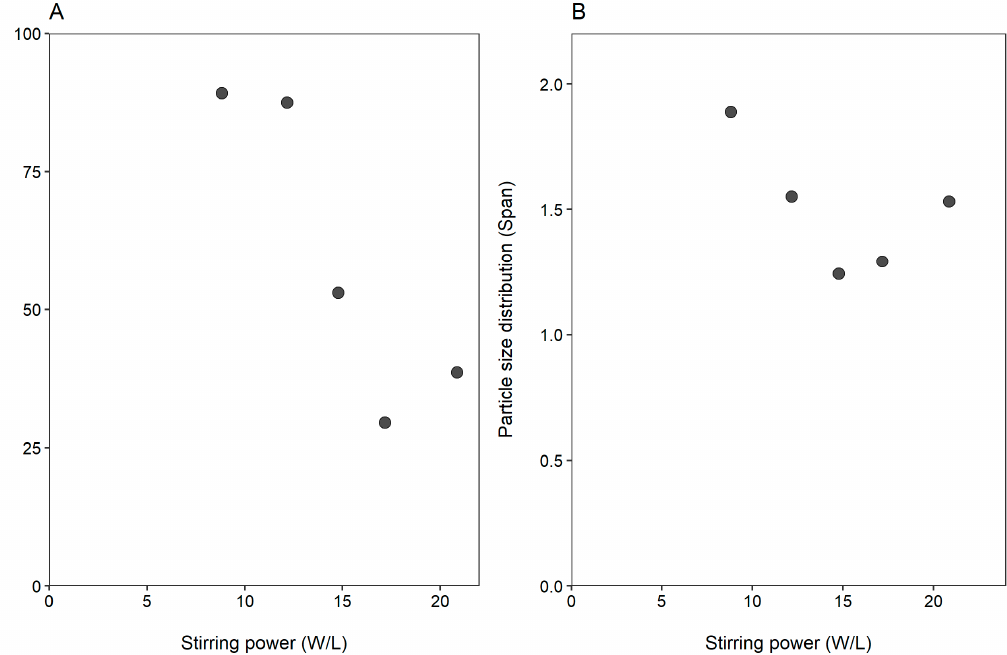
Figure 5. The effect of stirring power (W/L) on the ( A ) particle size (d(0.9)) and ( B ) particle size distribution (Span).